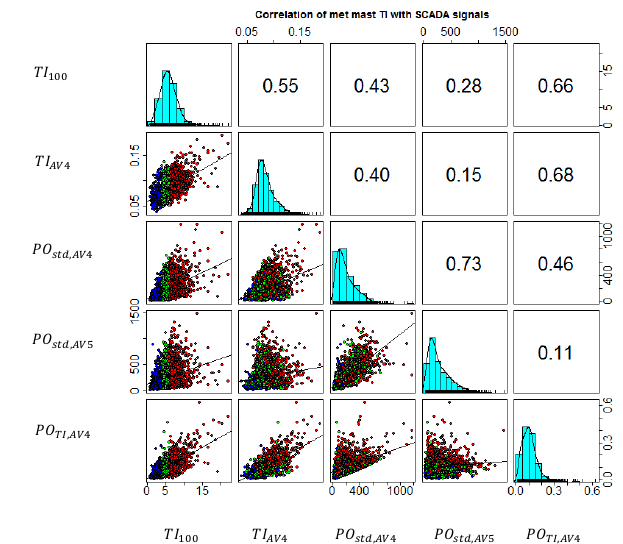
𝑃𝑂 𝑊𝑇 , 𝐴𝐴4 Figure 13. Normalised SCADA signal (PO TI cation of the magnitude of wake